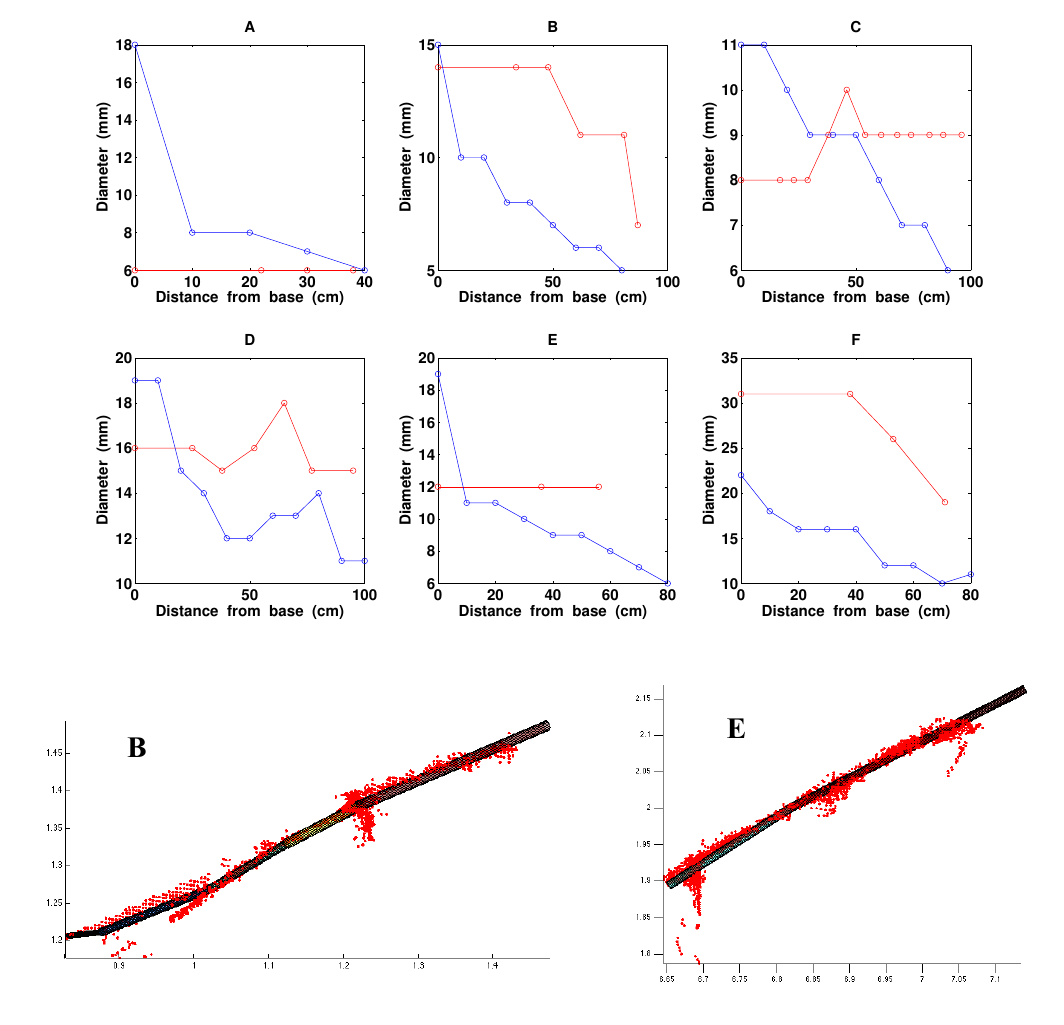
Figure 15. Comparison of measured and computed branch profiles for thin branches. The graphs below show the measured (blue) and computed (red) profiles: diameter in mm as a function of branch length in cm. Below are the fitted cylinders for the profiles B and E. The red points are the laser data